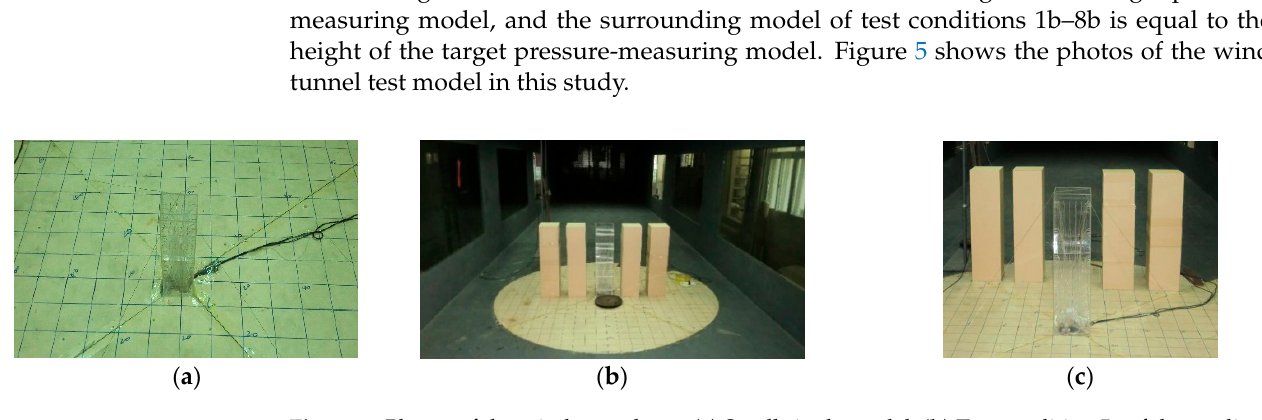
Table 2. The blockage ratio of each test condition.